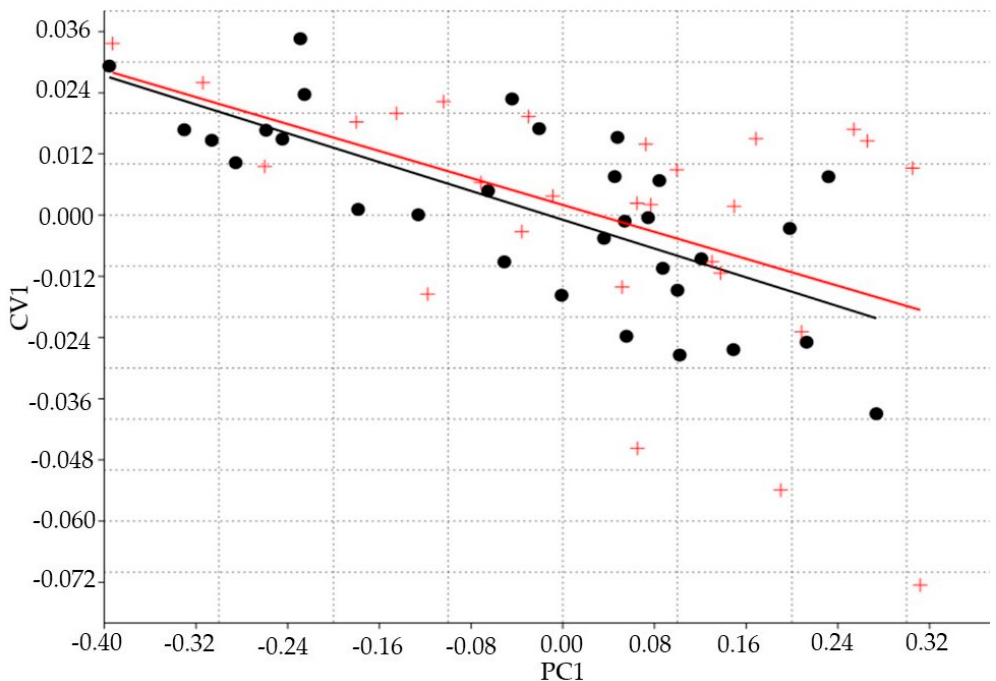
Figure 3. Relationship between the scores of canonical variate analysis (CV1) and the generalized size (first principal component PC1) in individuals of both sexes of Araucan pig (31 males, ● , and 27 females, +). There were no statistical differences between genders ( p = 0.534).